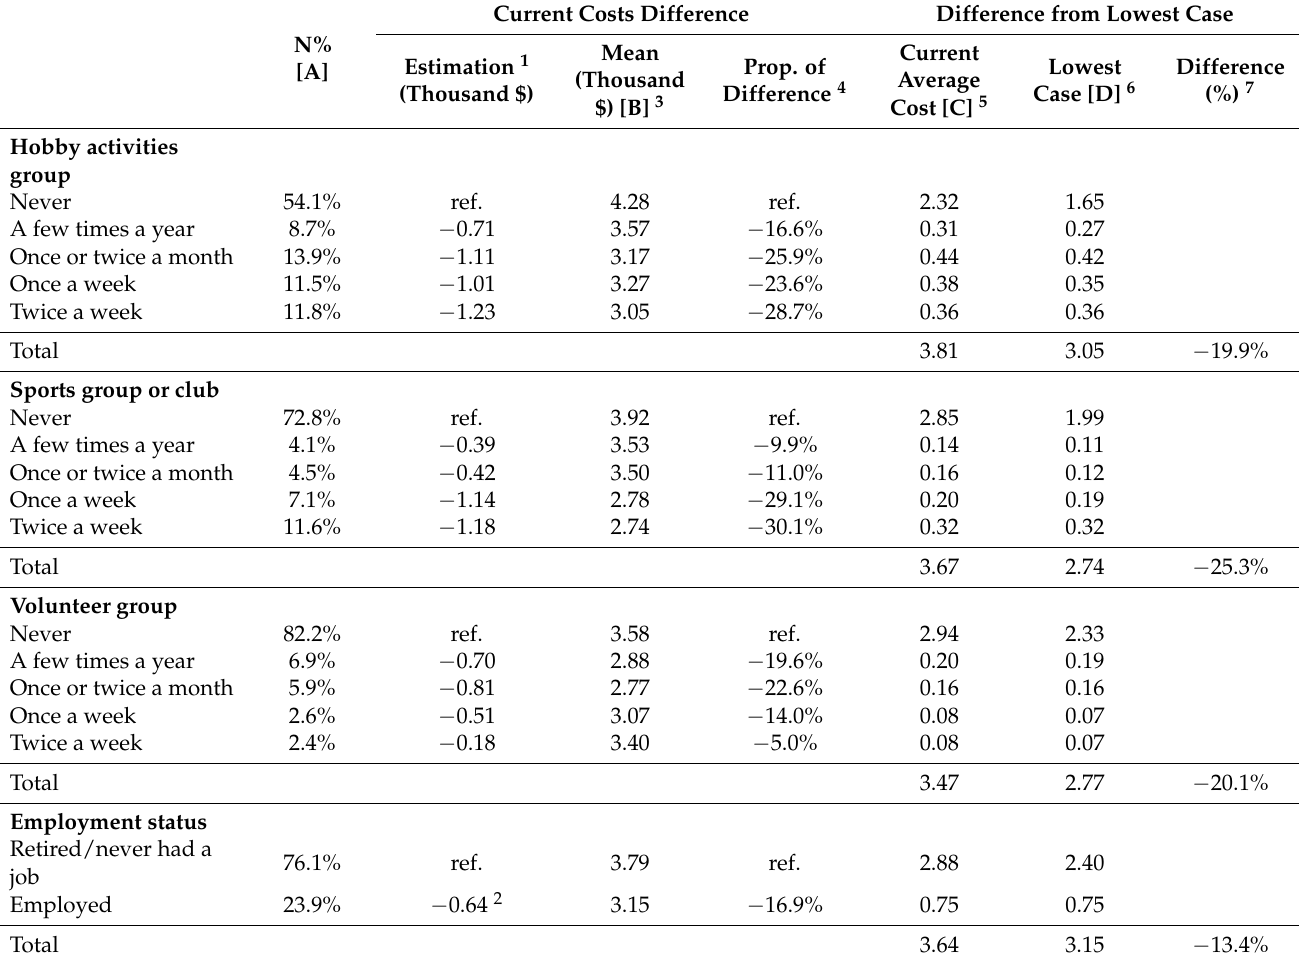
Table 3. Proportion of differences in cumulative LTC costs by community activities and employment